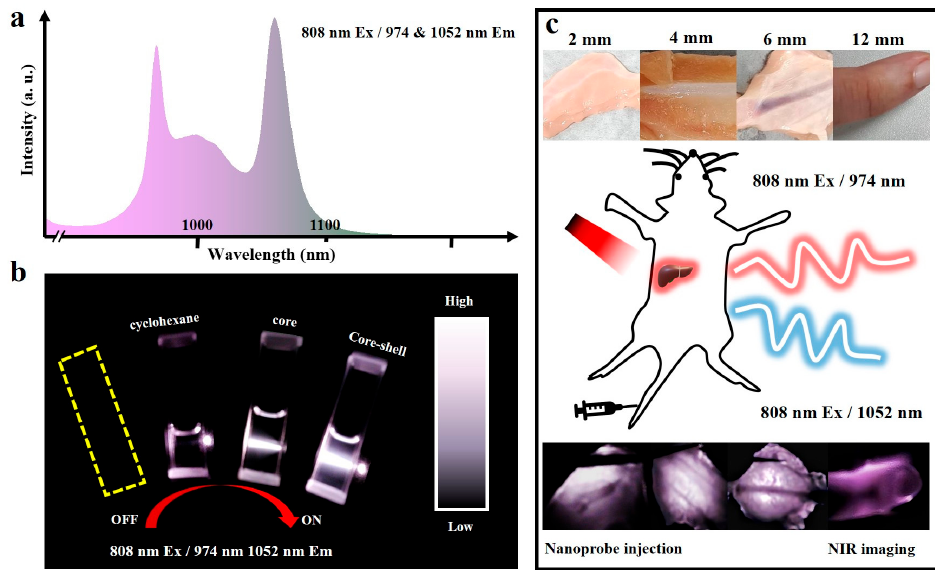
Figure 5. ( a ) The selected NIR imaging interval. ( b ) NIR luminescence of nanoparticles. ( c ) Schematic of biological tissue imaging of nanoparticles.